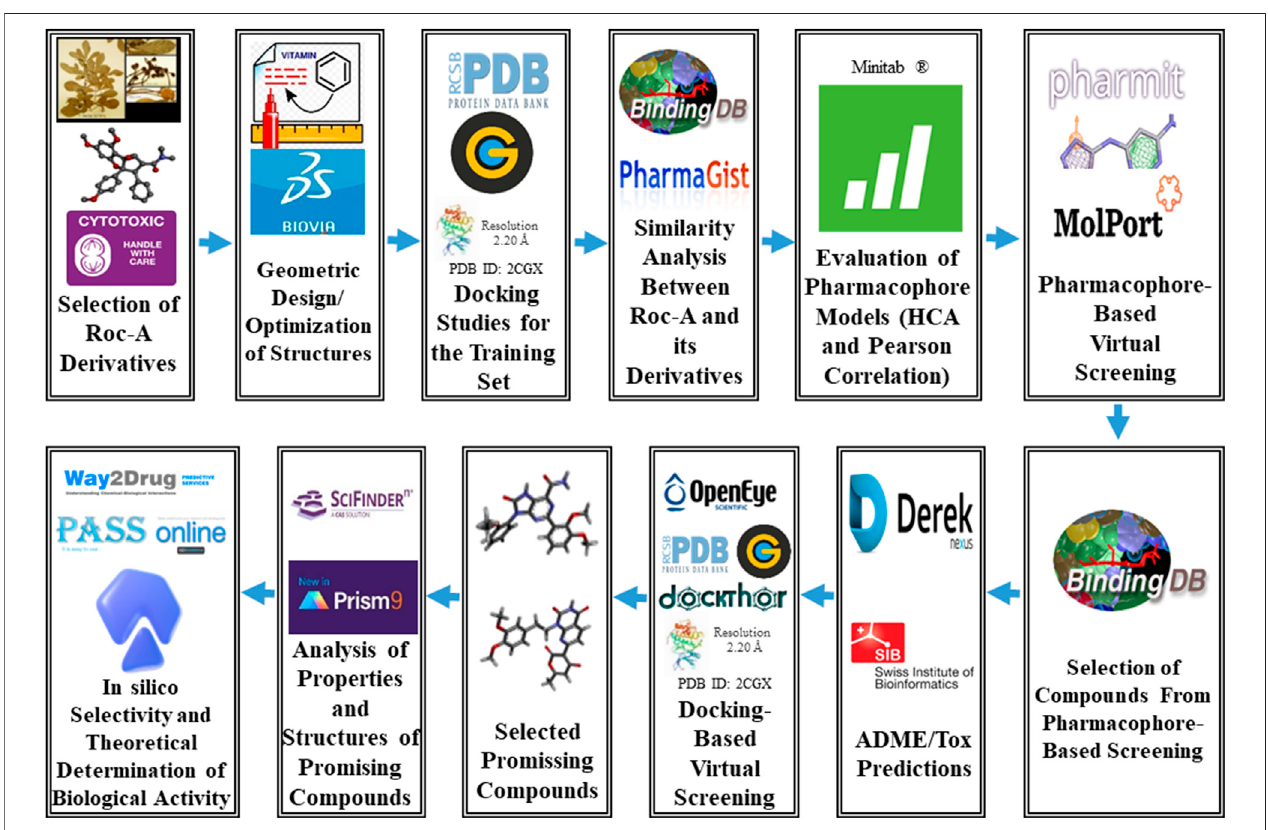
FIGURE 2 | General scheme summarizing the methodological steps proposed via hierarchical virtual screening in this work.